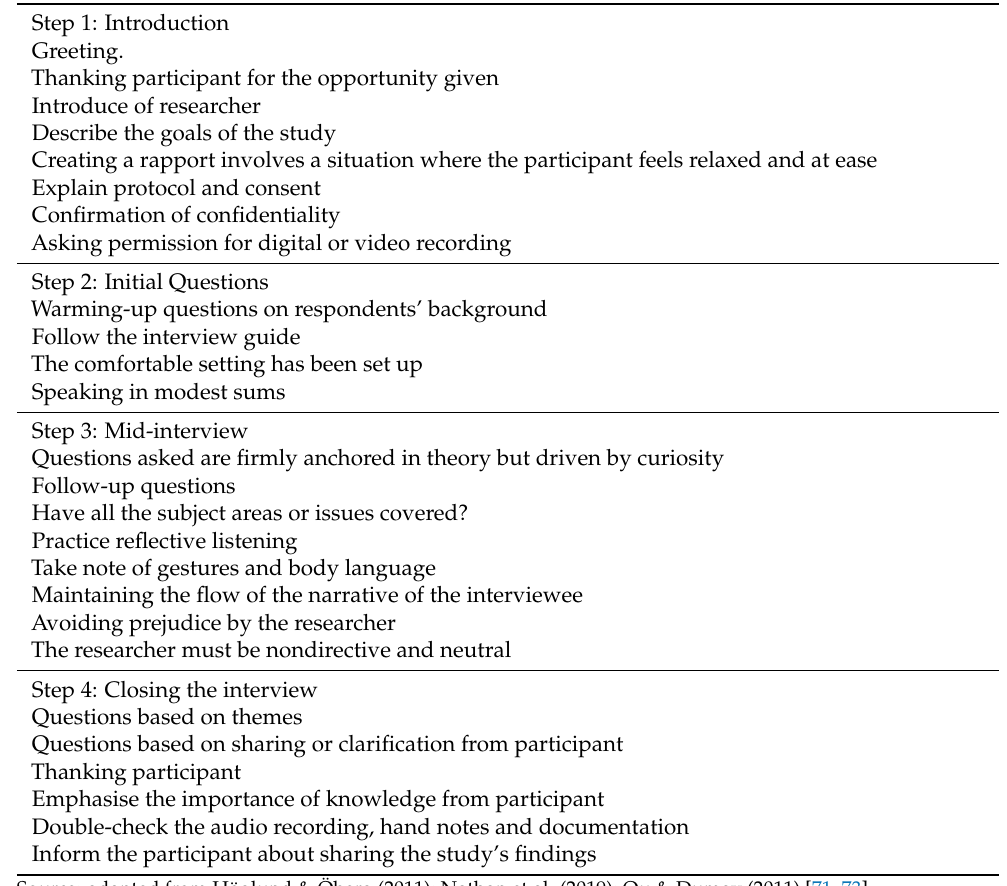
Table 3. The Flow of Interview Process of this